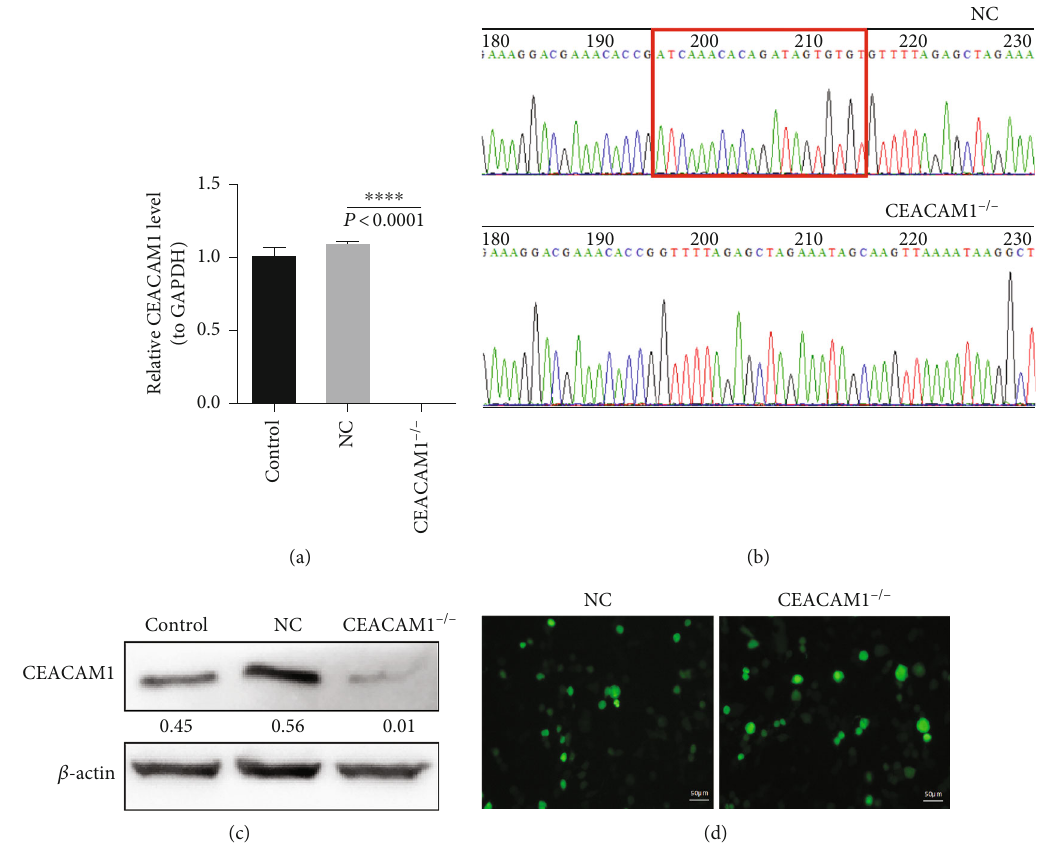
Figure 2: HPMVECs infected with mutated CEACAM construct exhibit reduced CEACAM protein expression. (a) Quanti fi cation of CEACAM1 expression in control and mutant HPVMECs. (b) CEACAM1 knockout was con fi rmed by DNA sequencing. The mutation is highlighted by a red box. (c) CEACAM1 mutant cells exhibit reduced CEACAM protein expression compared to control HPMVECs by Western blot. (d) shows that successful constructions of CEACAM1 -/- and negative control stably transfected cell